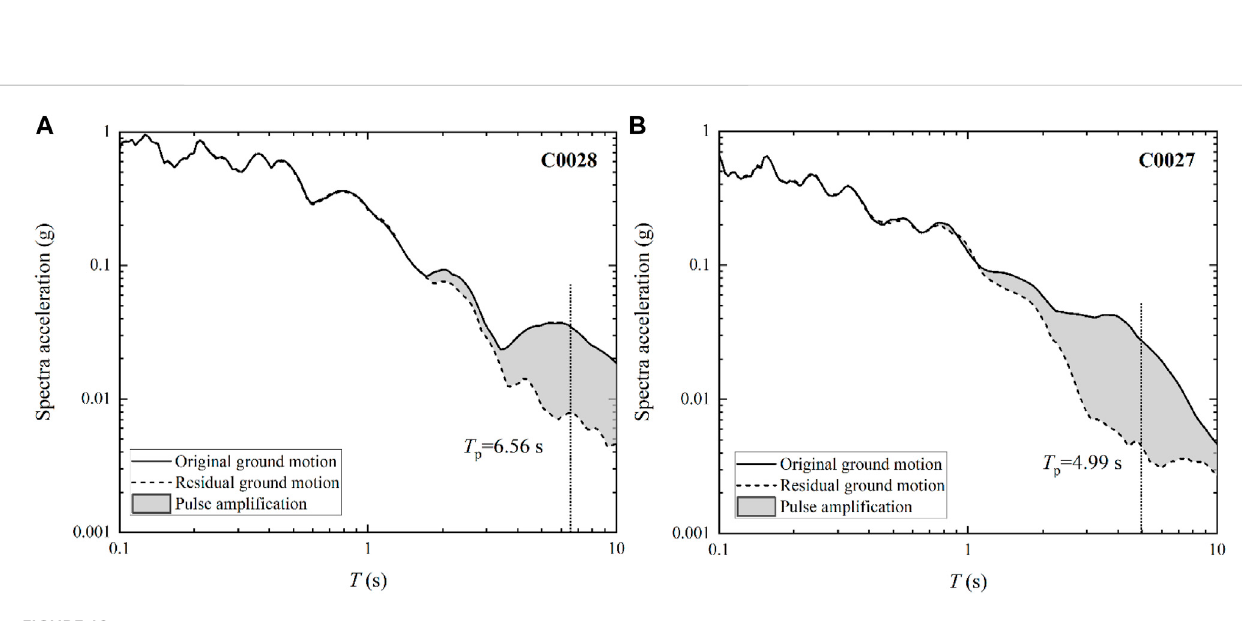
Frontiers in Earth